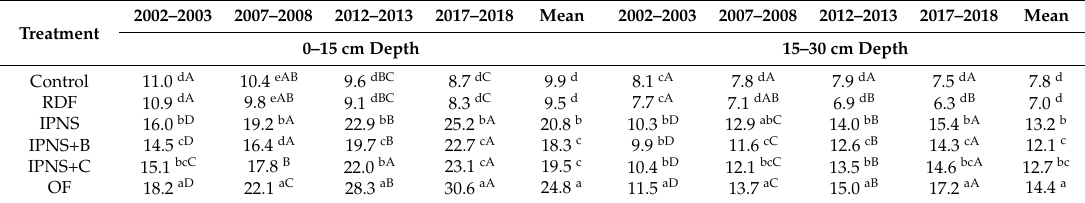
Table 8. Effects of different nutrient management options on the soil available S content (mg kg − 1 ) at soil depths of 0–15 and 15–30 cm after 5 RWS cycle intervals.